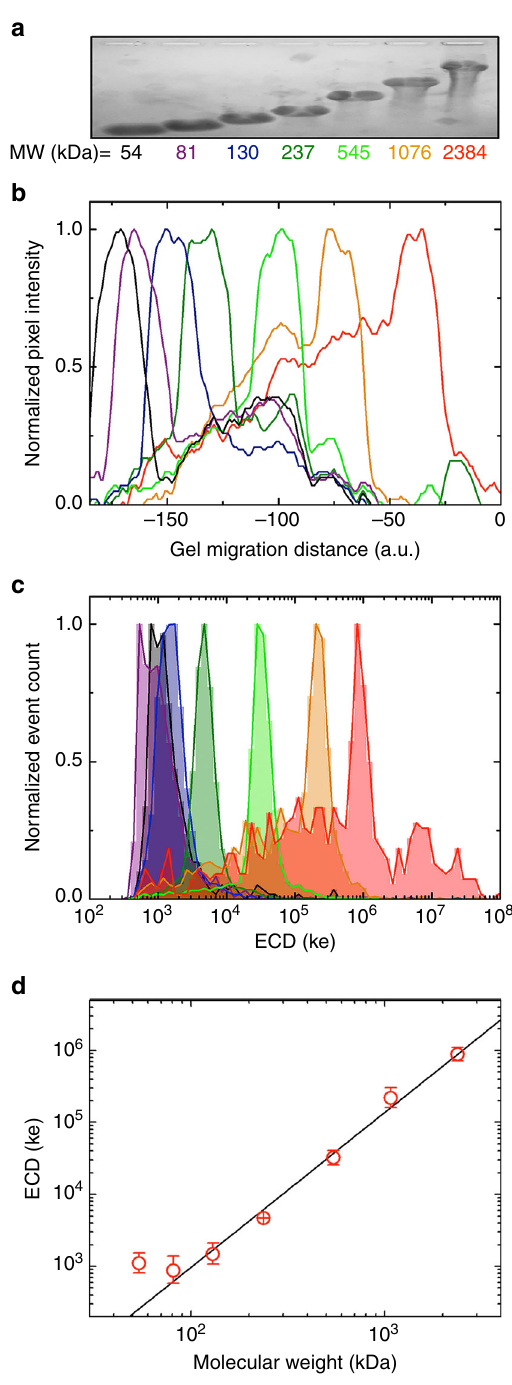
Fig. 3 SS-nanopore analysis of quasi-monodisperse HA. a Gel image of quasi-monodisperse HA samples. b Normalized electropherogram of gel image intensity for each MW sample. Colors match MW labels used in a . c ECD histograms for each MW sample measured at 200 mV applied voltage, with number of events considered: 54 ( n = 344), 81 ( n = 1031), 130 ( n = 3667), 237 ( n = 7835), 545 ( n = 5012), 1076 ( n = 1743), and 2384 kDa ( n = 640). Colors match MW labels used in a . d Relationship between ECD measured by SS-nanopore and HA MW from c . Error bars represent the standard deviations of log-normal fi ts to the datasets. Solid line is a power law fi t ( α = 2.23) to the data down to 81 kDa